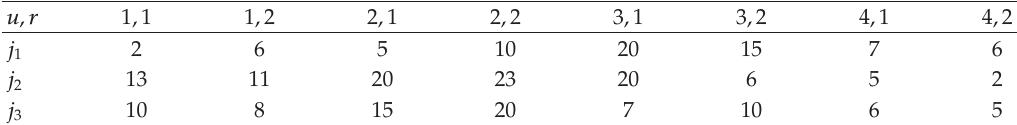
(cid:6) unit: train (cid:7) . j